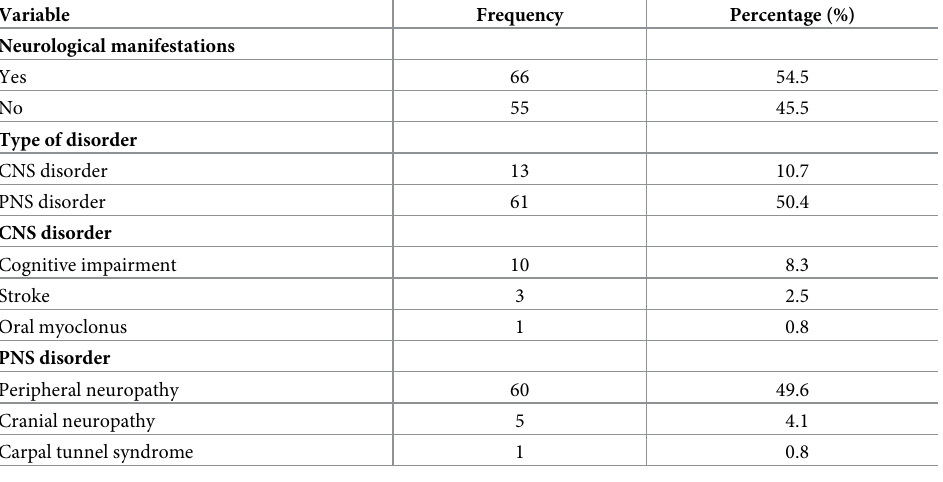
Table 4. Prevalence and clinical patterns of neurological